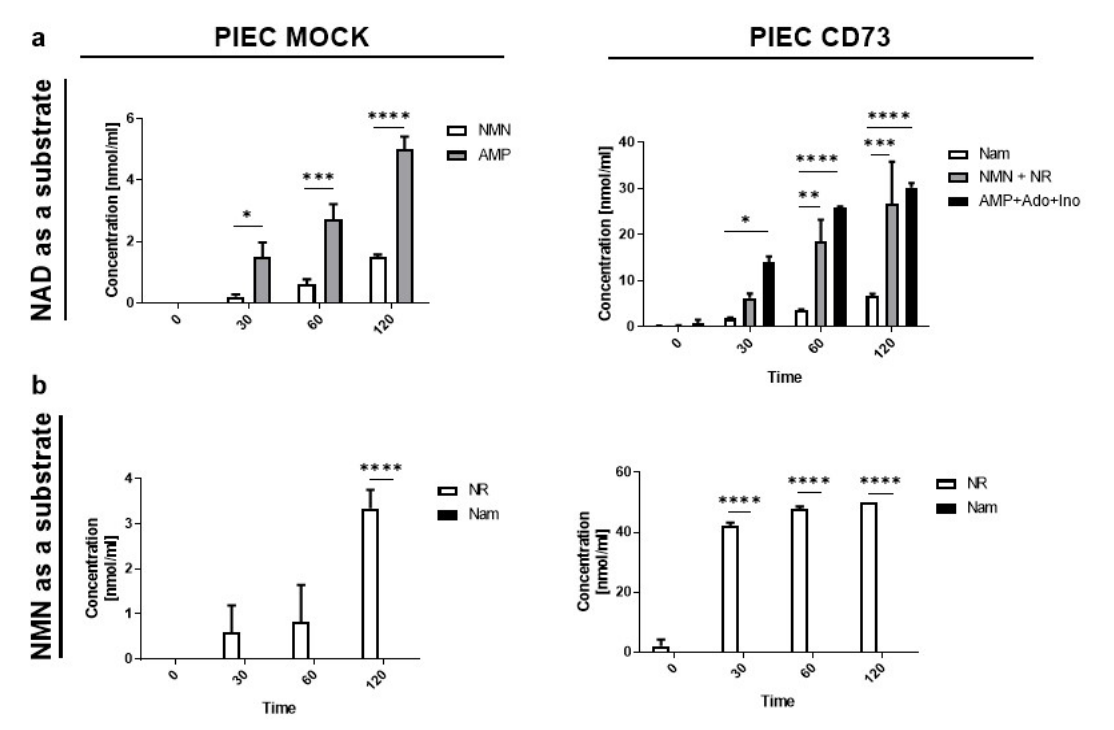
Figure 2. Transfected pig endothelial cells (PIEC) with the human CD73 gene show enhanced NAD + and NMN metabolism. Concentration of products after incubation with 50 µ M NAD + ( a ) and 50 µ M NMN ( b ) on the PIEC MOCK (control) and PIEC CD73. Results are presented as the mean ± SEM; n = 3–6 with two-way ANOVA followed by Tukey’s posttest. * p < 0.05, ** p < 0.01, *** p < 0.001, **** p < 0.0001.